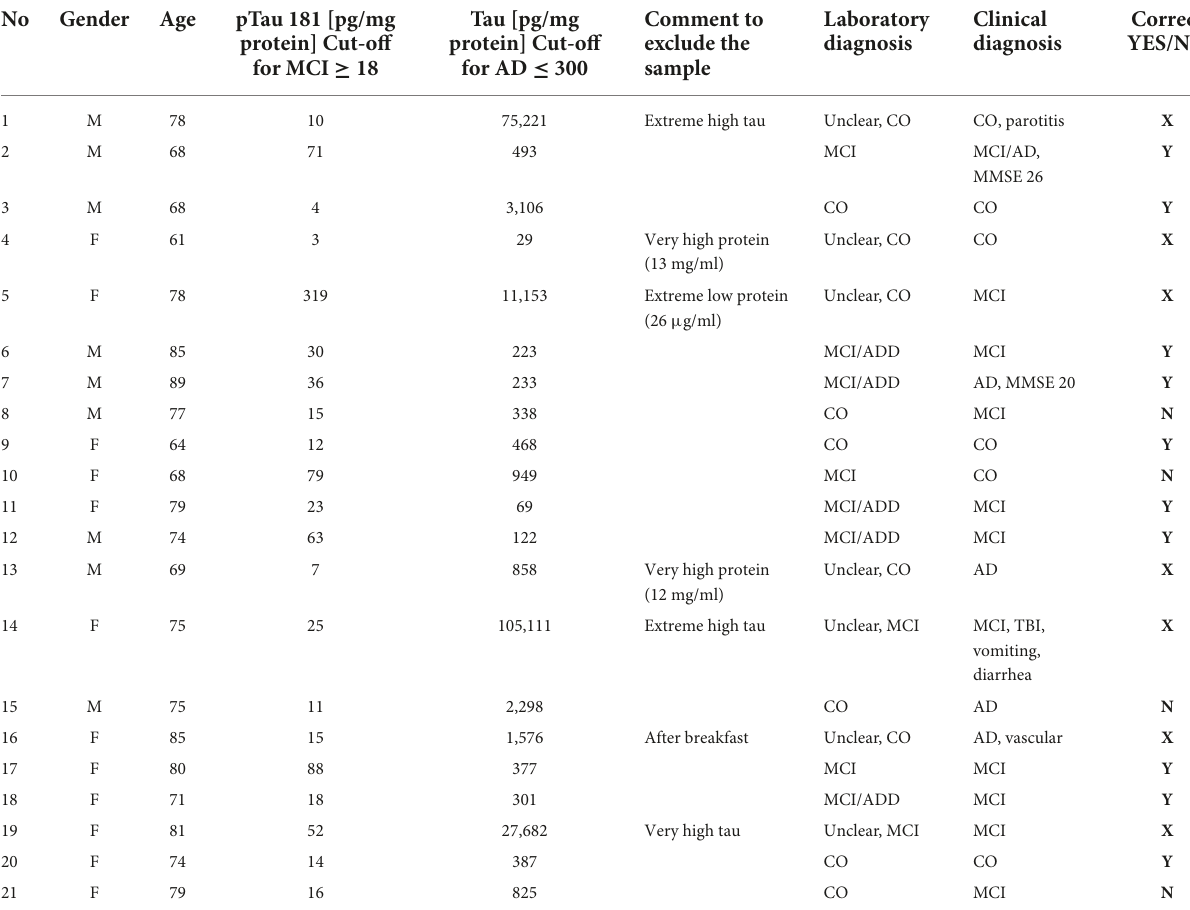
TABLE 2 Blinded verification of the